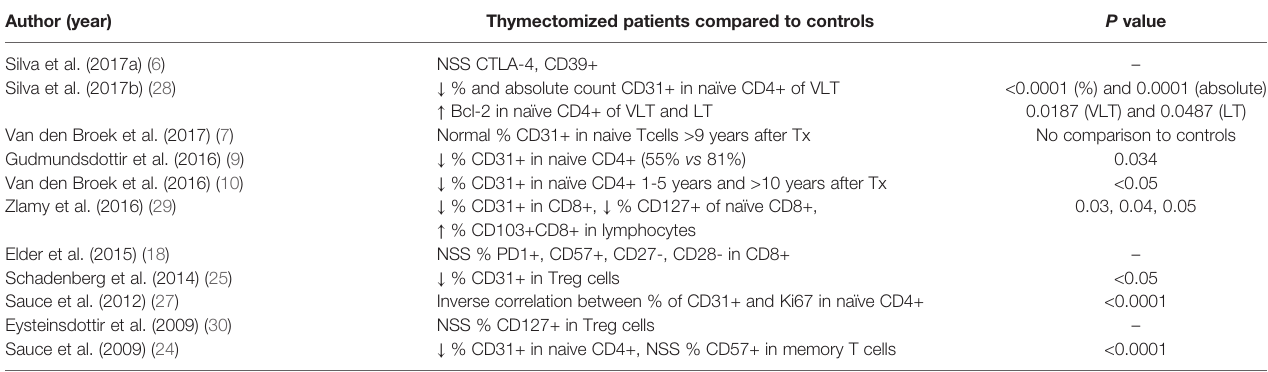
TABLE 7 | Main results regarding levels of other markers of included